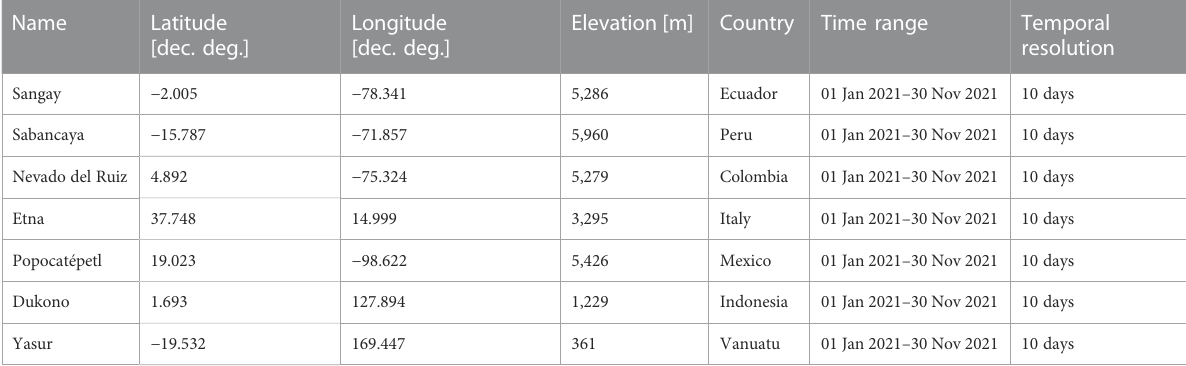
TABLE 3 Contents of the evaluating